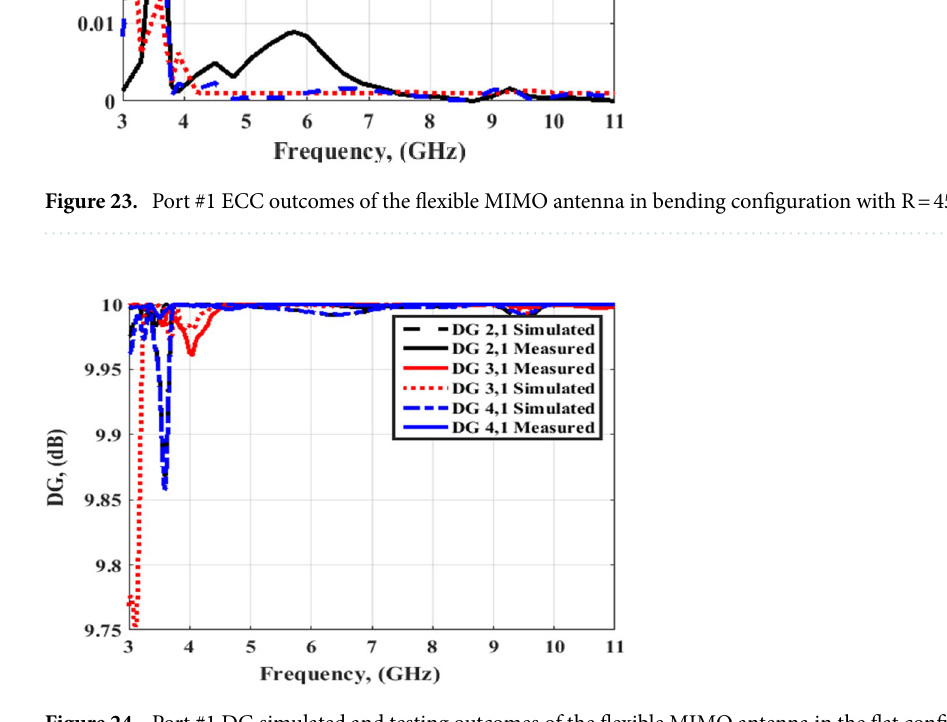
Figure 24. Port #1 DG simulated and testing outcomes of the flexible MIMO antenna in the flat